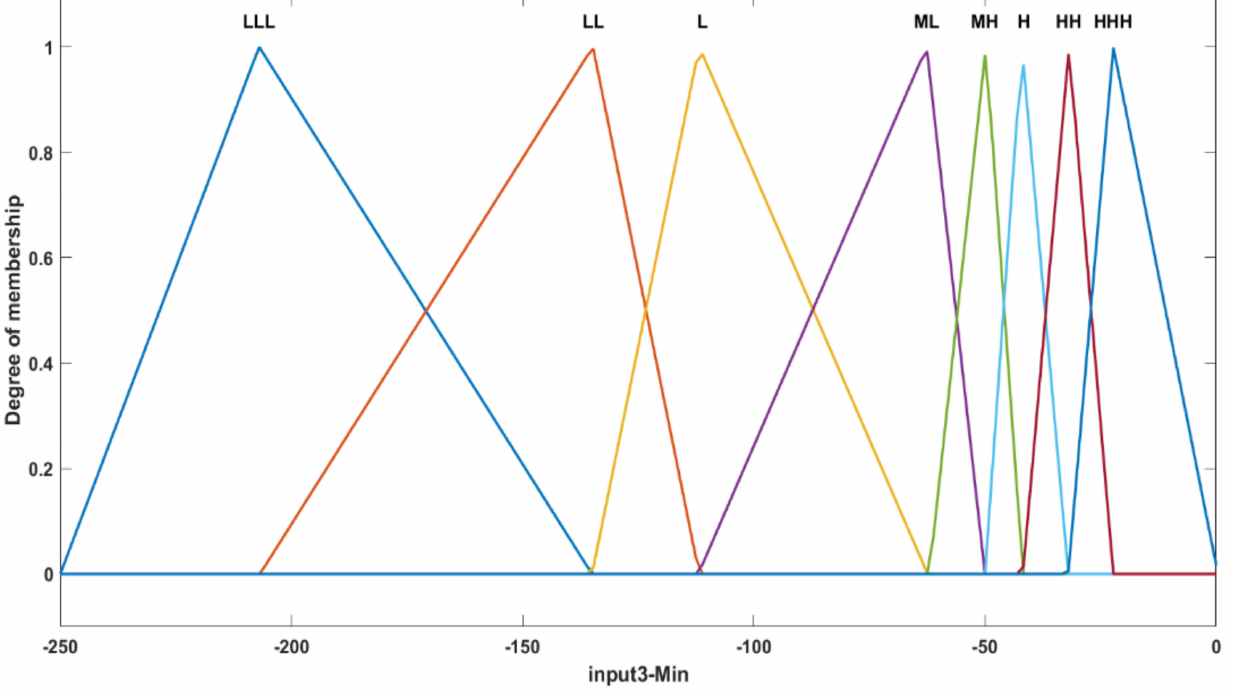
Figure 8. The membership function for input-3 to the fuzzy classifier based on the min values of frequency responses. Based on these generated membership functions degrees for each fault class, a total of 12 rules are defined for 12 different fault situations to obtain the IF–THEN rule base part of the Sugeno type fuzzy classifier. The rules created for each fault class are shown in Table